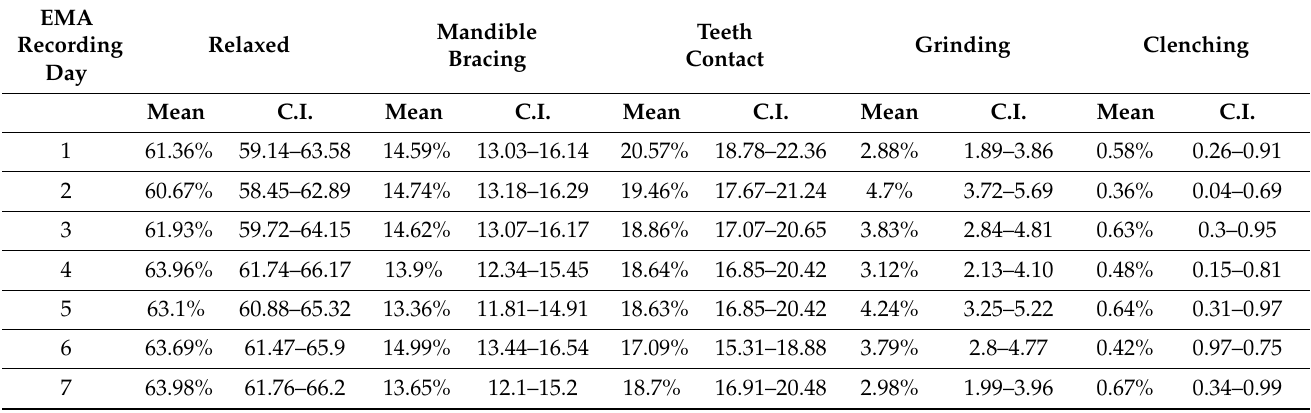
Table 4. Mean percentage of frequencies and confidence intervals (C.I.) of Oral Behaviours (OB) recorded with the Ecological Momentary Assessment (EMA) at different timepoints.